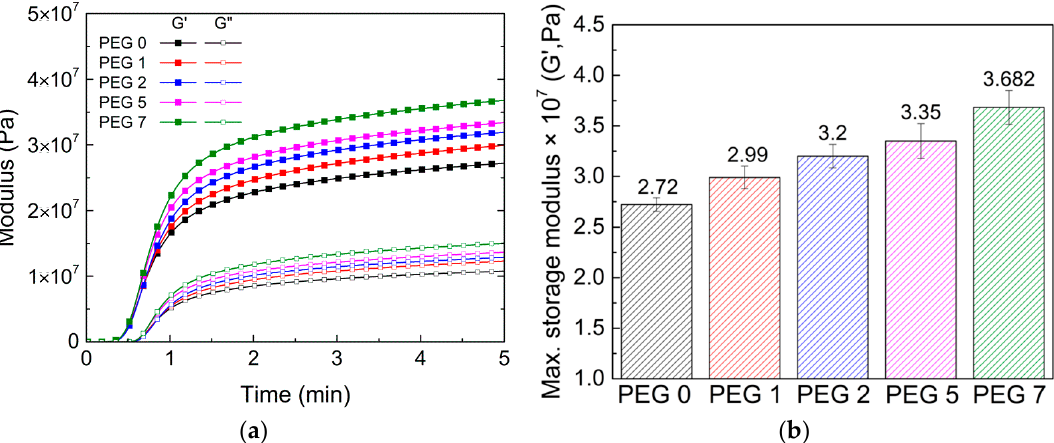
Figure 3. ( a ) Real-time storage modulus (G ′ ) and loss modulus (G ″ ) during ultraviolet (UV) irradiation and ( b ) maximum G ′ for the PEG-GMA hydrogel mixtures with varying G-SiNP contents.